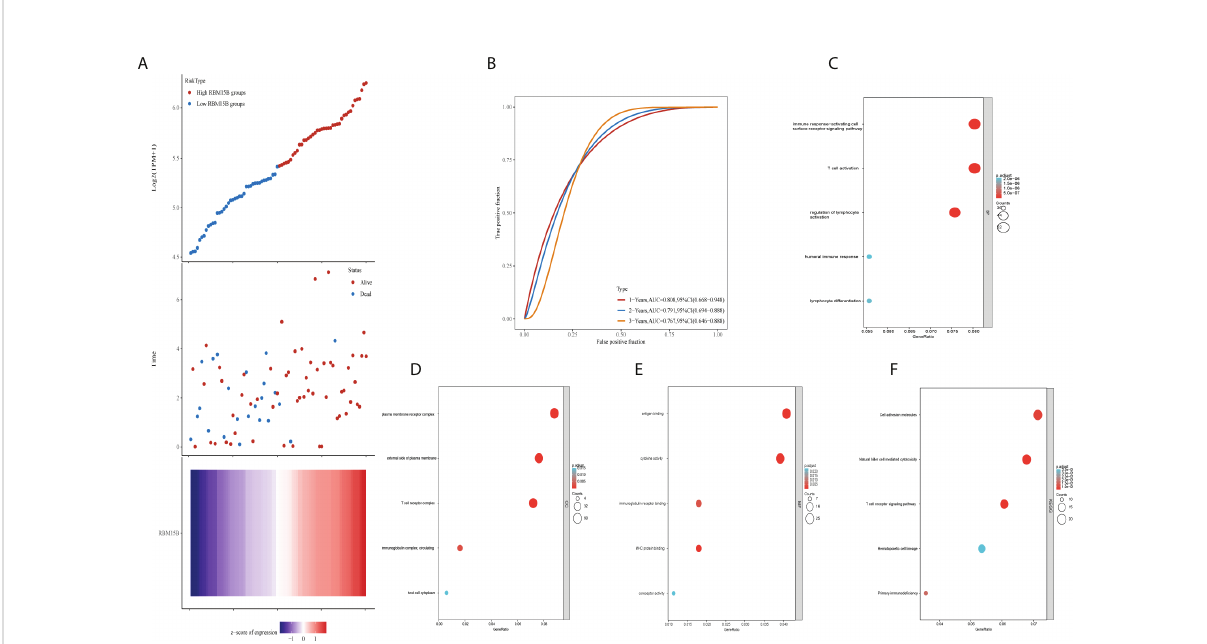
FIGURE 4 Prognostic value and GO and KEGG analysis of RBM15B. (A) Patients were divided into low and high groups based on RBM15B expression. (B) Time-dependent receiver operating characteristic analysis of RBM15B. Bubble charts showed the top 5 elements of (C) Biological process; (D) Cellular component; (E) Molecular function; and (F) Kyoto encyclopedia of genes and genomes analysis. GO, gene oncology, KEGG, kyoto encyclopedia of genes and